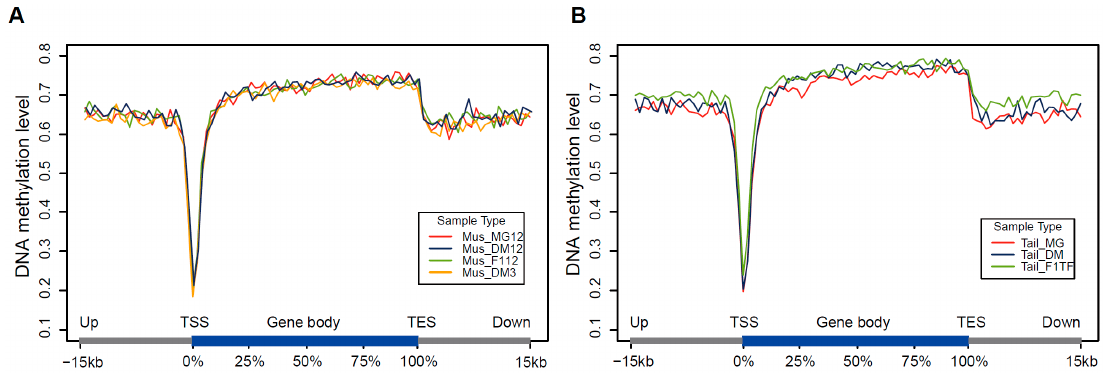
Figure 3. DNA methylation dynamics of gene body and flank regions. DNA methylation dynamics of ( A ) muscle tissue and ( B ) tail-fat tissue, averaged DNA methylation levels along the gene body and 15 kb upstream of TSS and 15 kb downstream of TES of all annotated RefSeq genes.